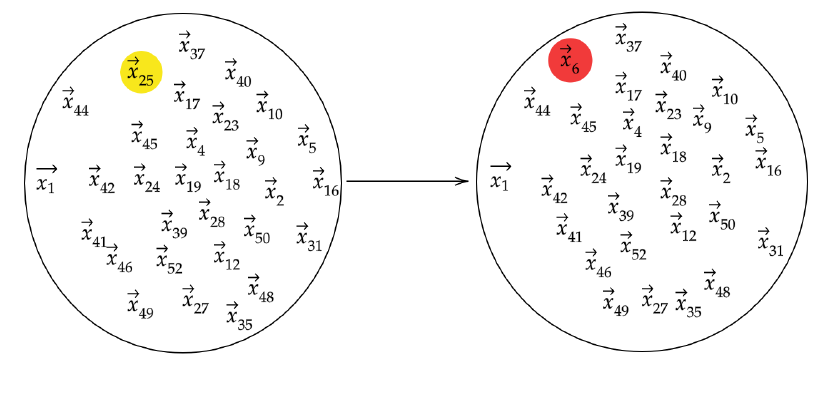
Figure 2. The left side represents one of the reference bags, while the right side represents the corresponding modified bag for week 6.